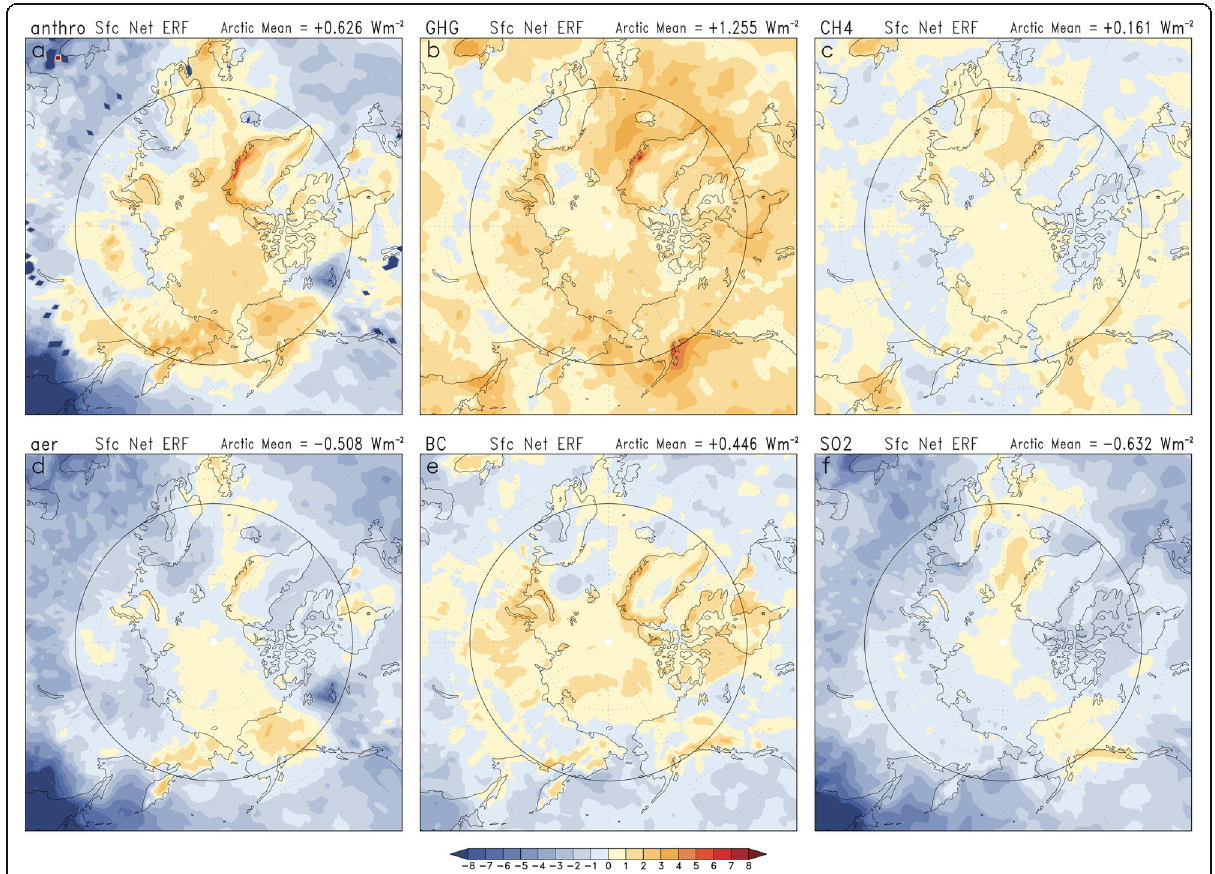
Fig. 10 Same as Fig. 9 but for the net (net, shortwave + longwave) ERFs at the surface